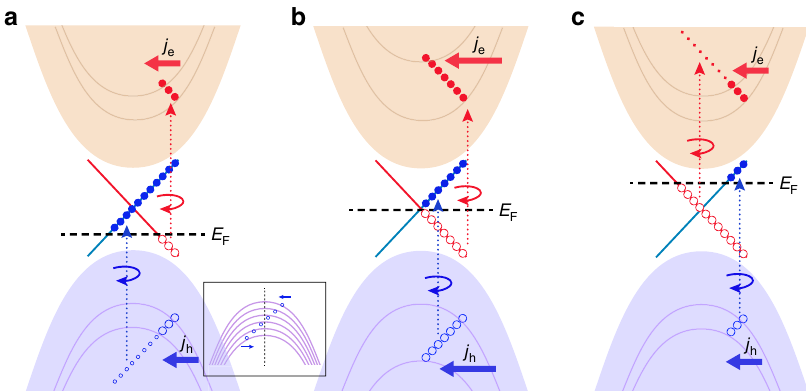
Fig. 5 Schematic picture to explain the chemical potential dependence of the HDPC. a – c denote the chemical potential below, near and above the Dirac point, respectively. The bulk bands are assumed to be continuous in the energy range of the photons and the surface states are perfect Dirac bands. The red dotted arrows denote the preferred transitions from the surface states to conduction bands ( s → c ), while the blue dotted arrows denote the preferred transitions from the valence bands to surface states ( v → s ). The two transitions happen simultaneously and rely on the position of the chemical potential. a The chemical potential is below the Dirac point. The excited carriers are denoted by fi lled circles (electrons) and empty circles (holes). In the valence band, the excited holes are separated into two parts, one denoted by small circles and the other denoted by large circles . As shown in the sub-diagram, the small circles are distributed evenly around the Γ point, leading to zero total generated photocurrent. Therefore, only the large circles contribute to the net photocurrent. The net photocurrent induced by the bulk carriers is along the negative y direction and denoted by the arrows pointing to the left. The length of the arrows denotes the magnitude of the photocurrent. b The chemical potential crosses the Dirac point. The length of the arrows reach a maximum indicating the largest photocurrent. c The chemical potential is above the Dirac point. The excited carriers in the conduction band are separated into two parts and the small circles do not contribute a net photocurrent. Therefore, the length of the arrows denoting the net photocurrent